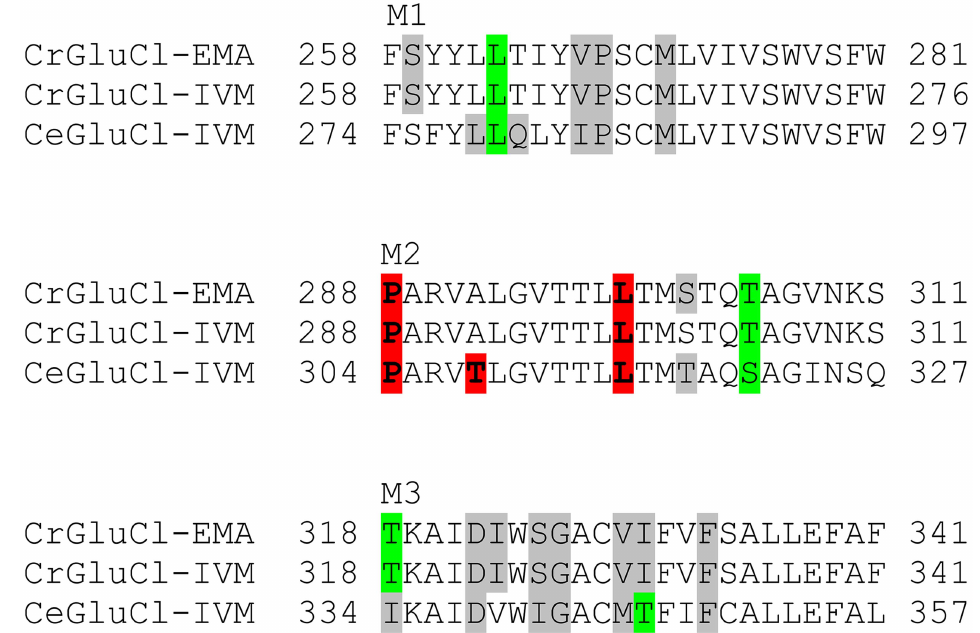
Figure 7. Conservation of residues involved in drug binding in Caligus and C.elegans GluCl a . Residues involved in hydrogen-bonding (green) and van der Waals (grey) interactions of ivermectin or emamectin with CrGluCl a (CrGluCl a -IVM, CrGluCl a -EMA, see text) are compared with those identified in the CeGluCl a -ivermectin complex (CeGluCl a -IVM) [16]. Only those interactions existing during . 70 ns of the 140 ns MD runs are shown. Residues highlighted in red are those apparently involved in creating a hydrophobic seal in the channel pore in the absence of agonists [31].